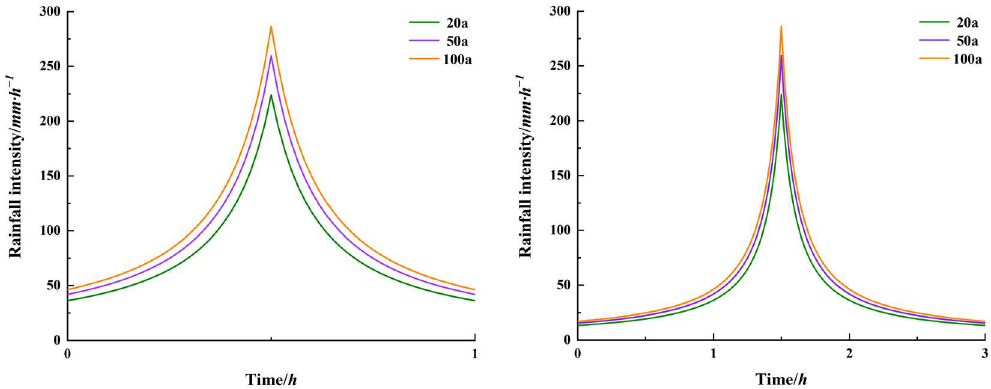
Figure 4. Design rainfall for each